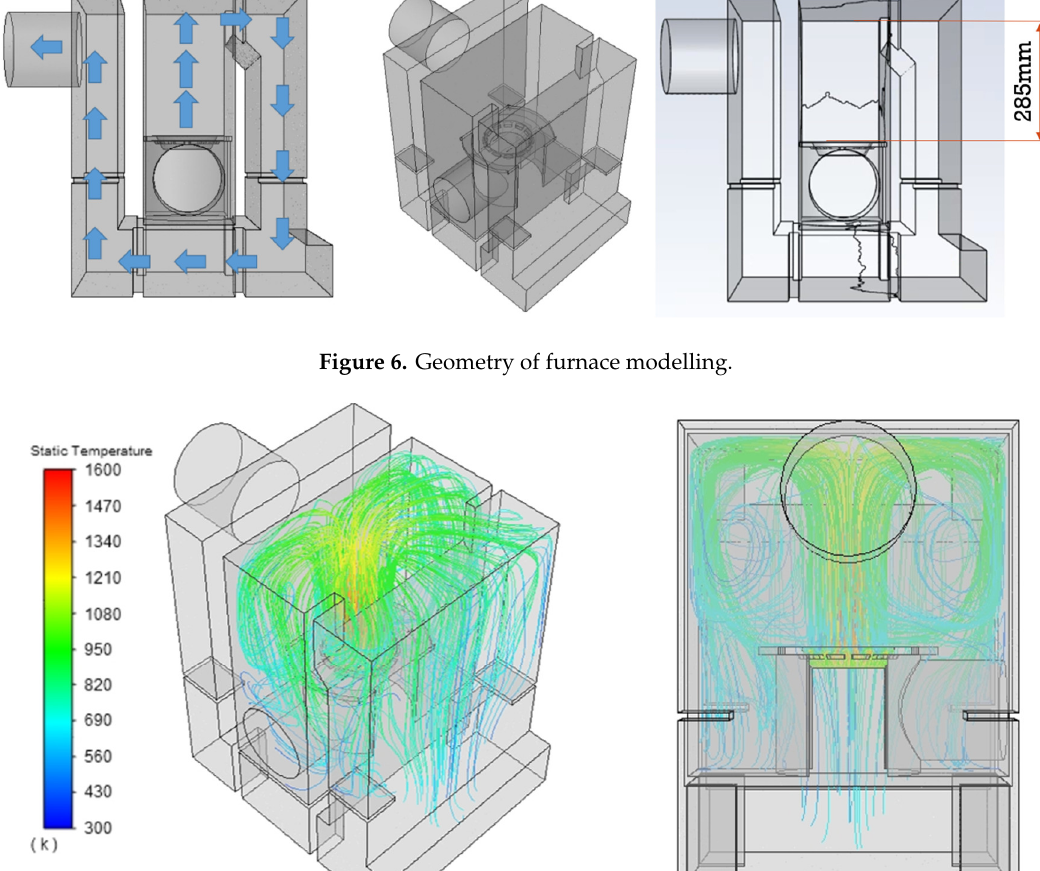
Figure 8. CO concentration (mole fraction). Figure 9. Temperature distribution (K) with determined temperature zone of above 880 K.